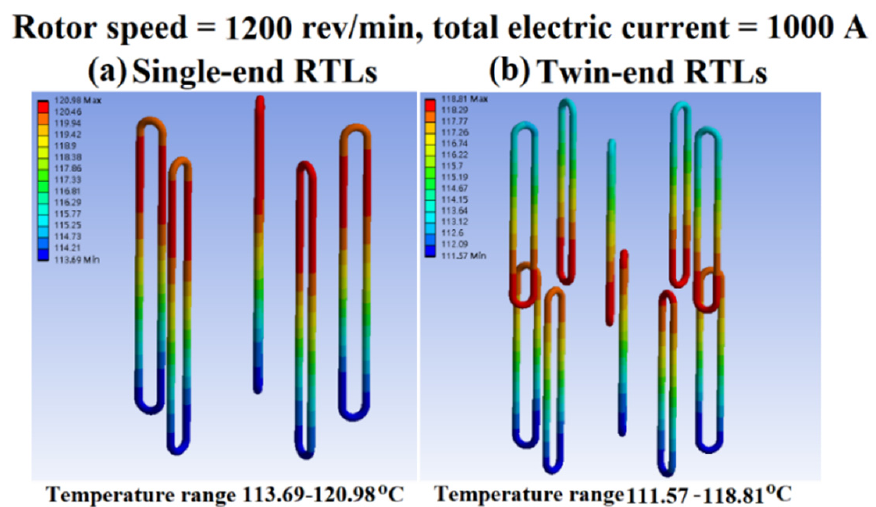
Figure 14. Surface temperatures on ( a ) single- ( b ) twin-end RTLs at T 0 operating condition.